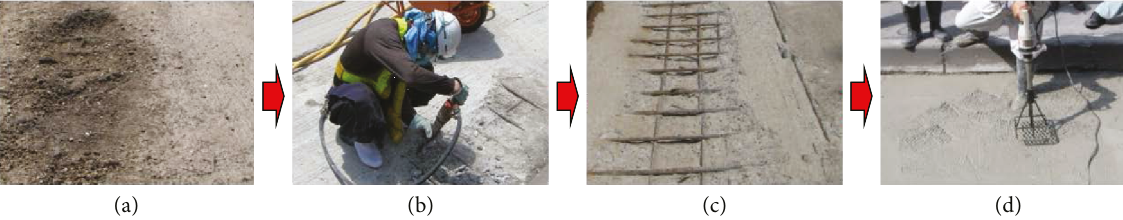
Figure 5: Example of thin-layer repair of upper layer of RC slab. (a) Degraded into aggregate. (b) Removal of damaged parts. (c) Removal of injured site. (d) Thin-layer repair.